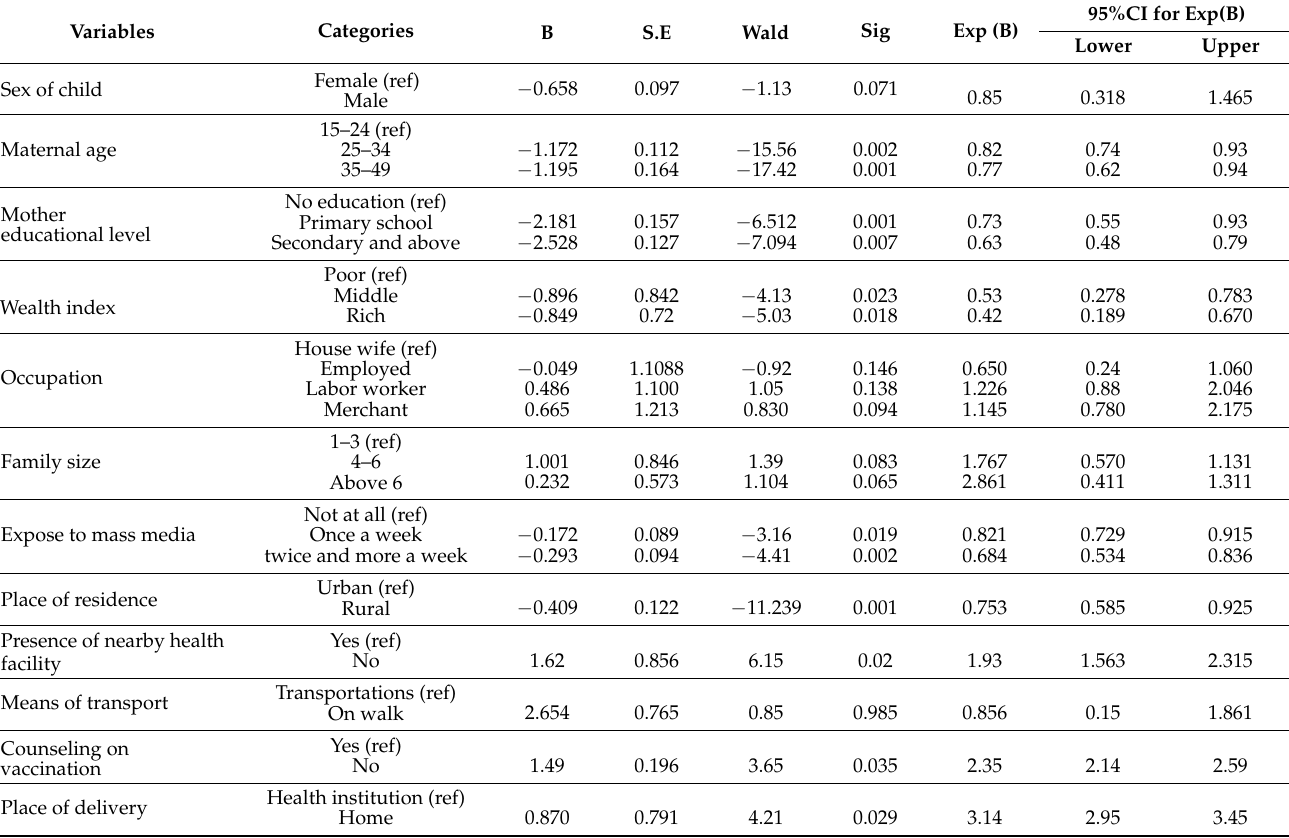
Table 2. Results of binary logistic regression